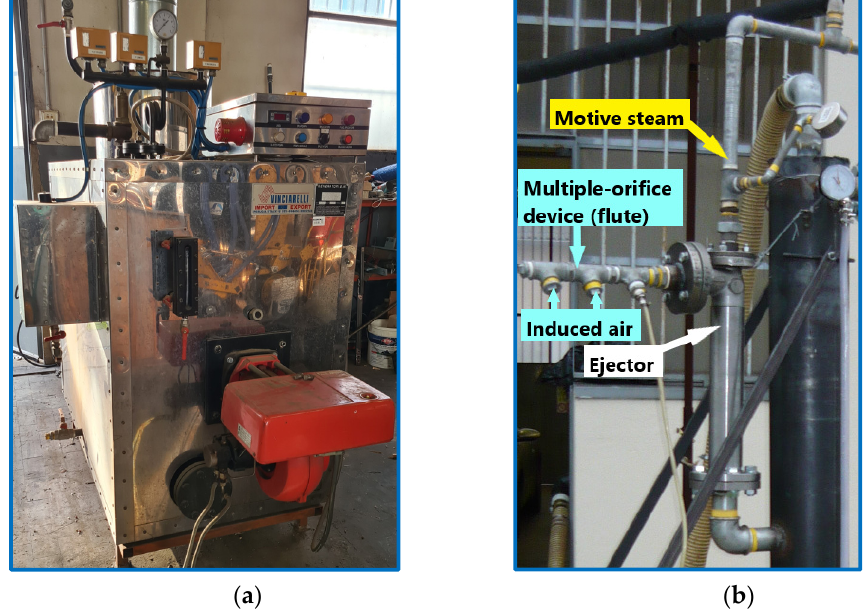
Figure 3. Bench tests of the ejectors 9 and 10: ( a ) Motive steam generator; ( b ) Ejectors during the tests: the induced gas was air, which passes through the calibrated orifices of the flute at sonic speed. The number and diameter of the orifices must be calibrated appropriately, in order to produce the suction mass flow rate G i and the pressure p i at the inlet of the suction chamber.